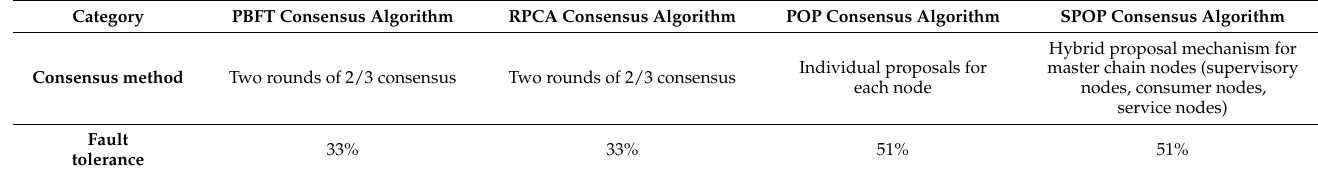
Table 5. Comparison table of